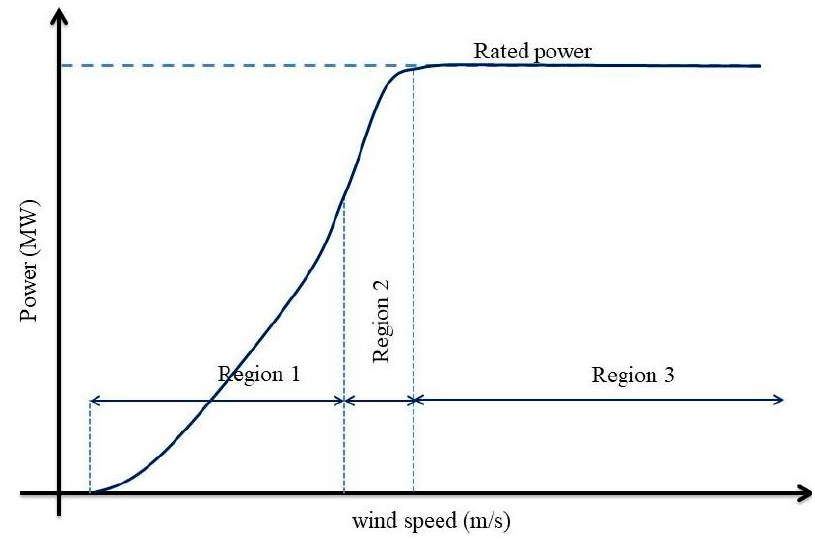
Figure 1. Power characteristics for different operating regions of a wind turbine.